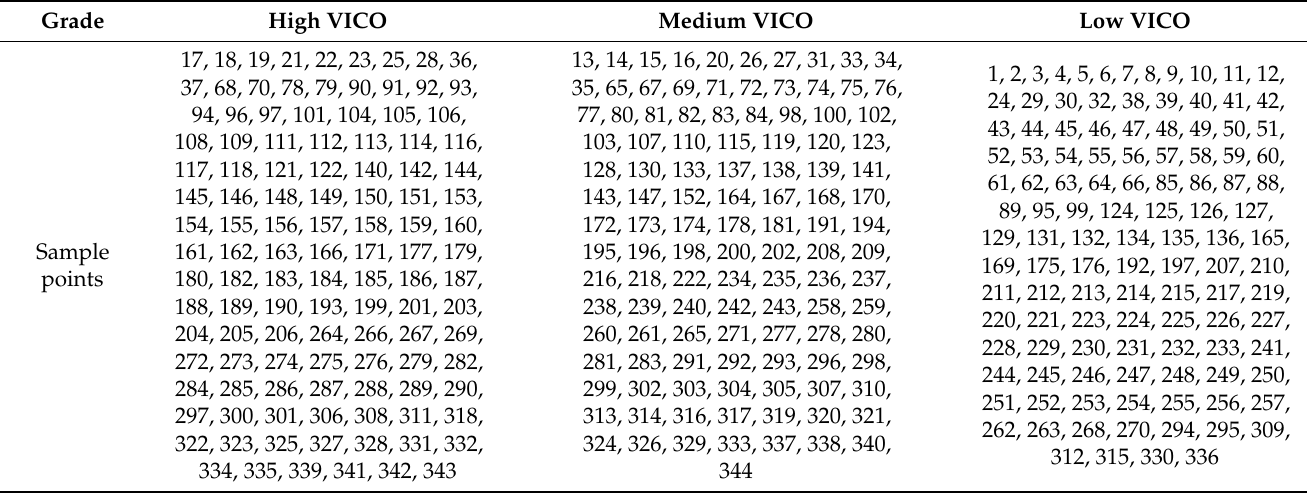
Table 2. The VICO grades of sample points.